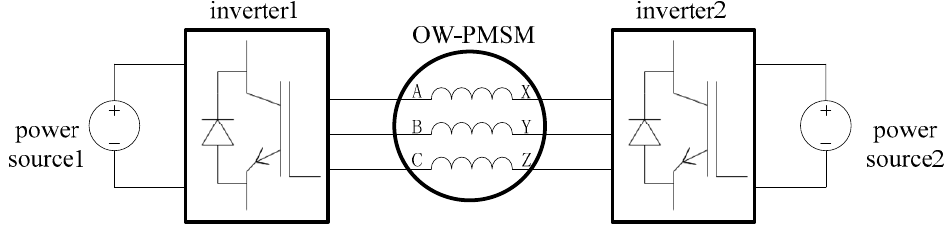
Figure 1. Structure of dual inverter open-end winding permanent magnet synchronous motor (OW-PMSM) drive system.